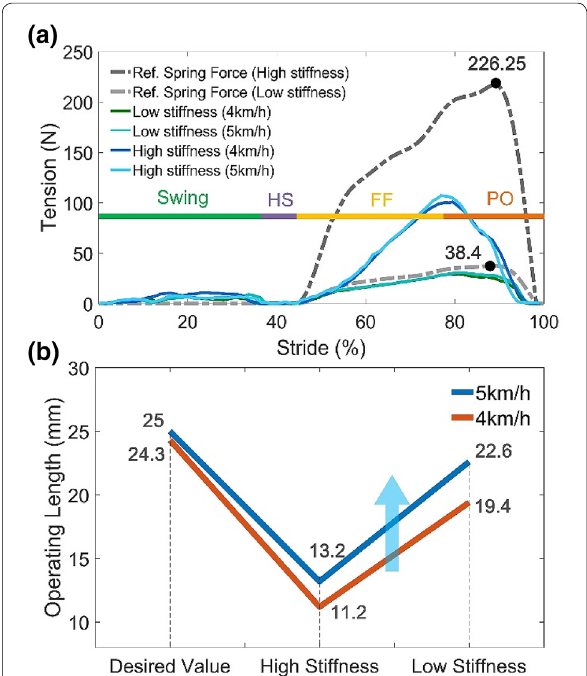
Figure 8 a Comparison of the reference spring forces and the actual assistance provided by the PAFE under different conditions. b The practical operating length measured by motion capture system